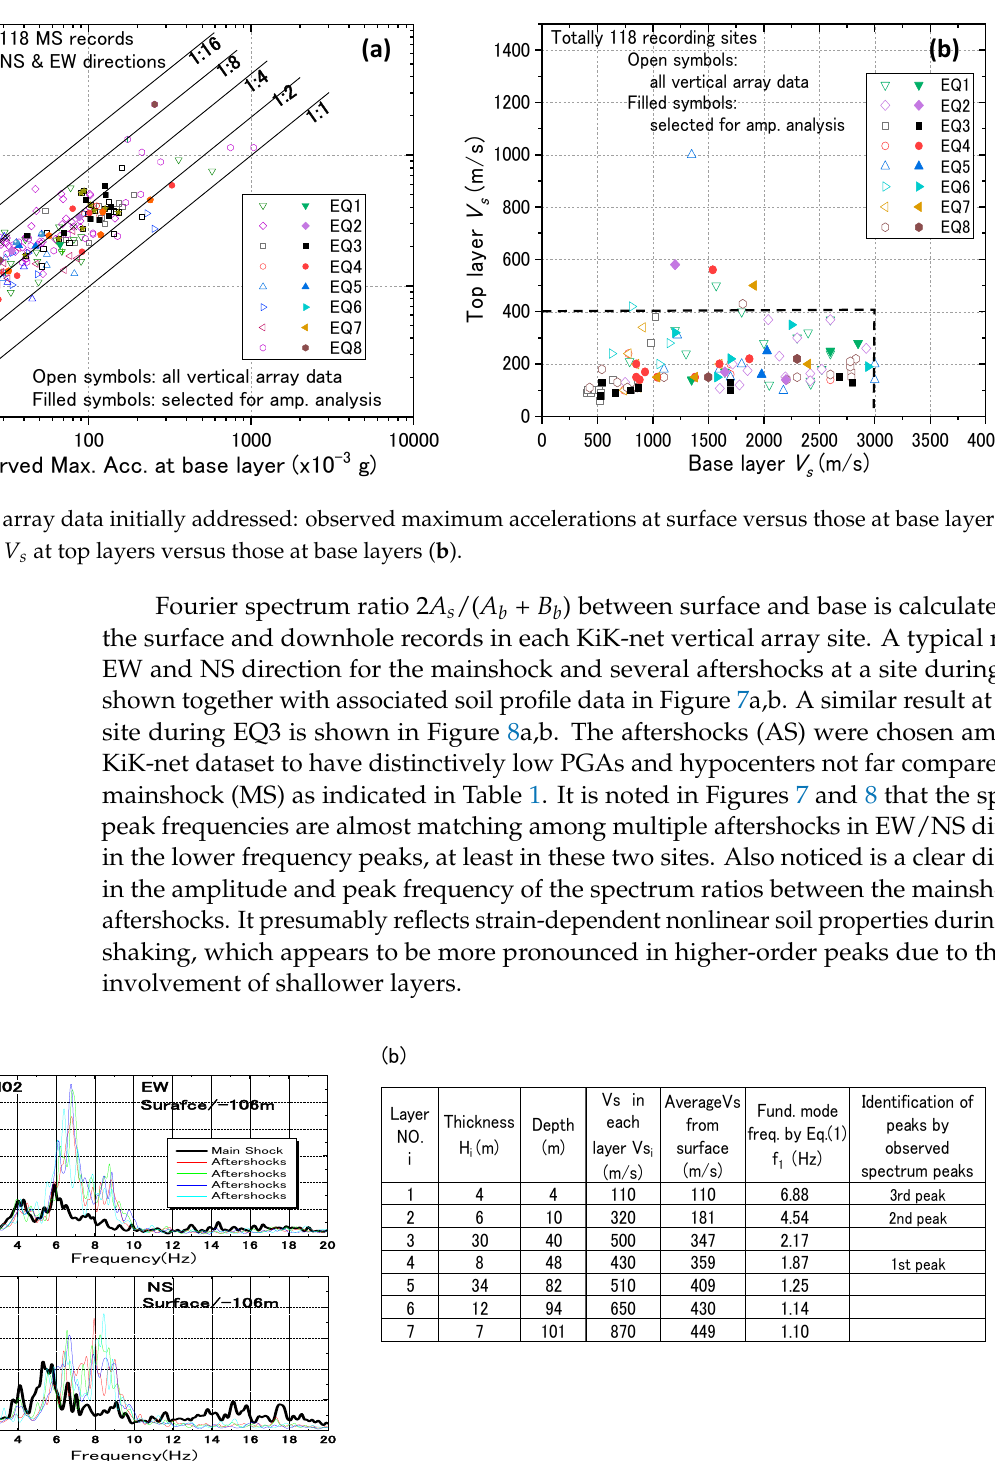
Figure 7. Fourier spectrum ratios of observed motions EW & NS ( a ), and Soil/ V s -profiles compared with spectrum peak frequency ( b ), at NMRH02 during EQ3.